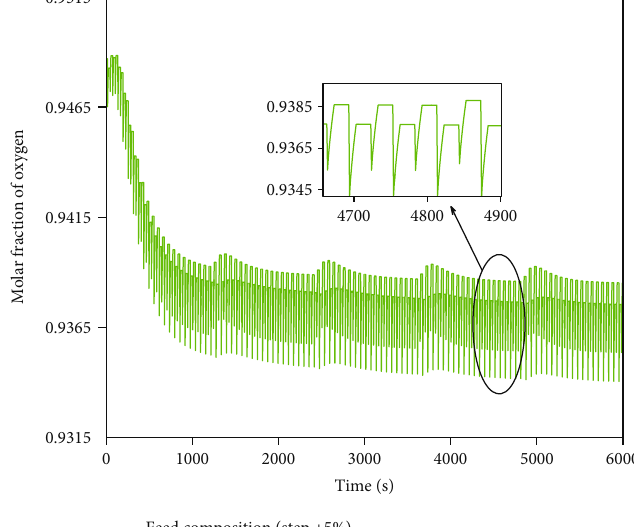
(g) Molar fraction: 0.78 (N 2 ) and 0.22 (O 2 ). to 0.741 (N 2 ) and 0.259 (O 2 ); Pressure: 150kPa to 157.5kPa; Flow: 0.89436528 kmolh -1 ; Temperature: 296.15K